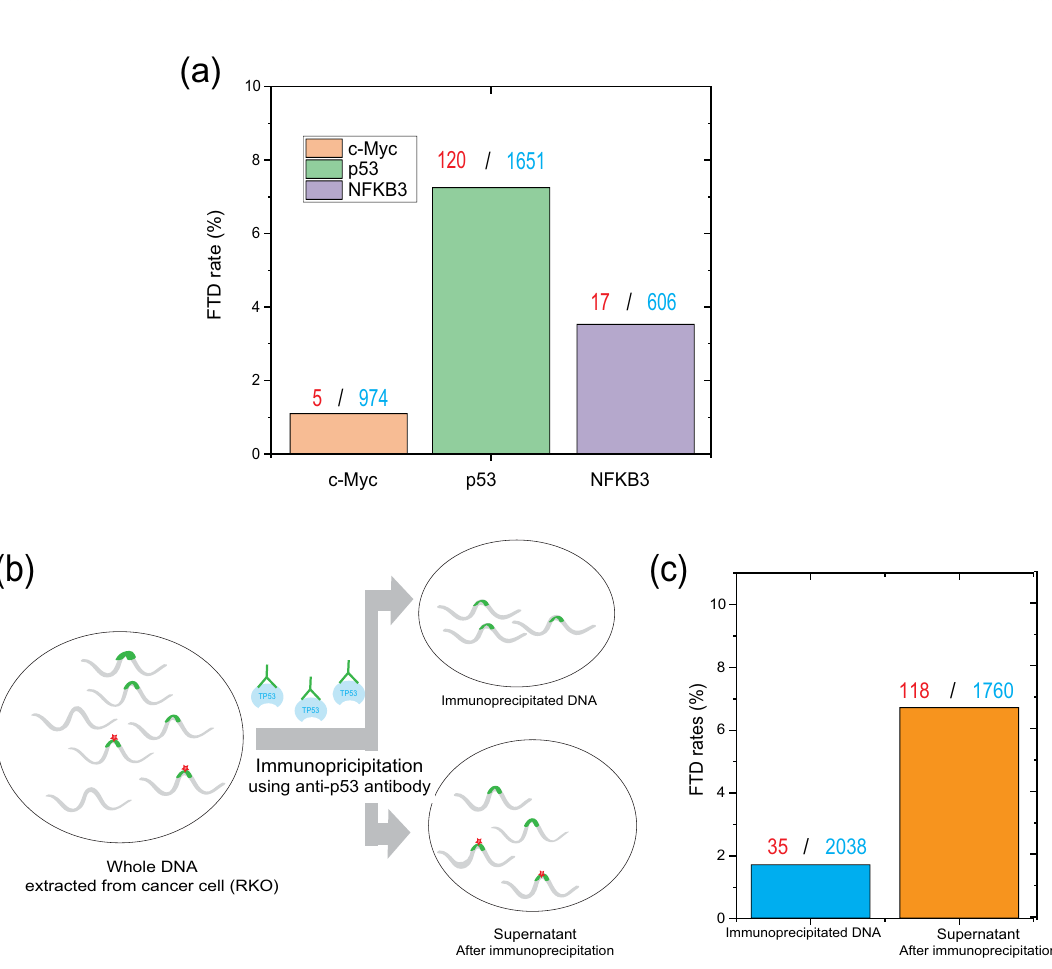
Figure 3. FTD incorporation of DNA and anti-p53 immunoprecipitation. ( a ) Dependency of FTD incorporation rates on the consensus-binding region of TF, i.e., c-Myc (orange), NFKB3 (purple), and p53 (green). Based on RNA analysis, the p53 and NFKB3 were impaired by FTD exposure, while c-Myc was not impaired by FTD exposure. The FTD rates for p53 and NFKB3 are larger than those for c-Myc. TRRUST, transcriptional regulatory relationships detected by sentence-based text-mining; FTD, trifluridine; TF, transcription factor. ( b ) Flowchart of the preparation of “immunoprecipitated DNA” and “supernatant DNA” by anti-p53 immunoprecipitation. To confirm the inhibition of binding ability with p53 to the binding motif, we prepared immunoprecipitated DNA using anti-p53 antibody, which was extracted from RKO cell lines, and the DNA that does not bind to anti-p53 antibody, which was the supernatant of the immunoprecipitated using anti-p53 antibody. ( c ) FTD incorporation rate for the p53 binding domain in the immunoprecipitated DNA using anti-p53 antibody (right), supernatant after immunoprecipitation using anti-p53 antibody